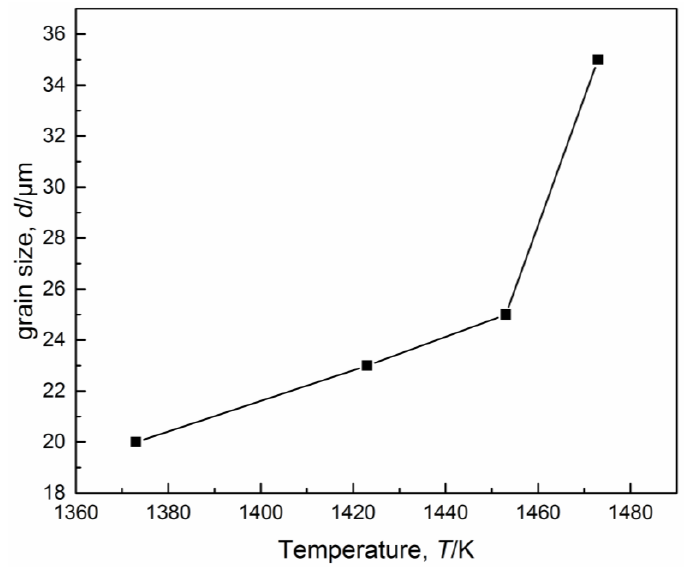
Figure 6. Relationships between grain size and austenitizing temperature.